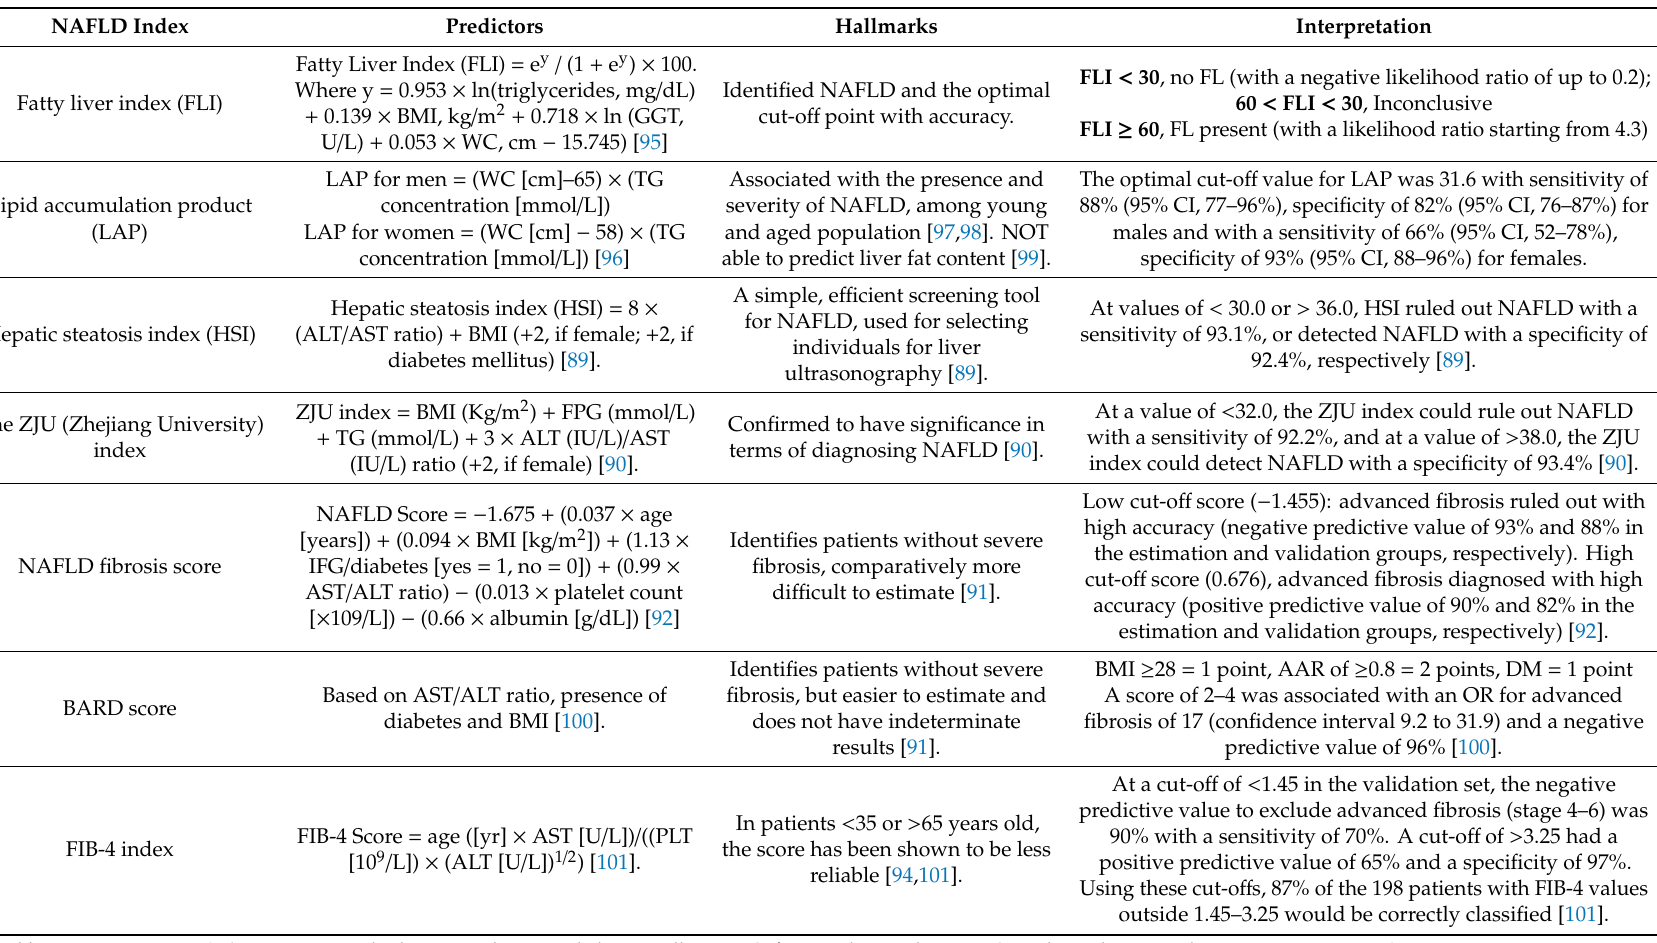
Table 1. NAFLD index and their